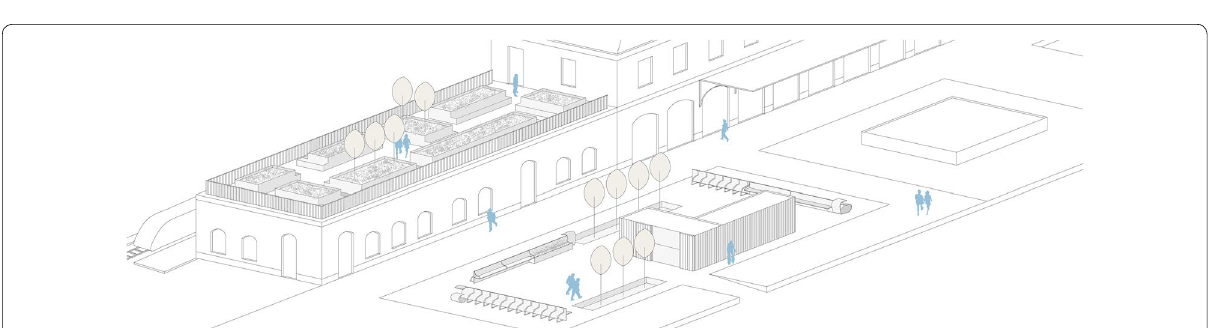
Fig. 12 Axonometric view of the external layout of Tortona station